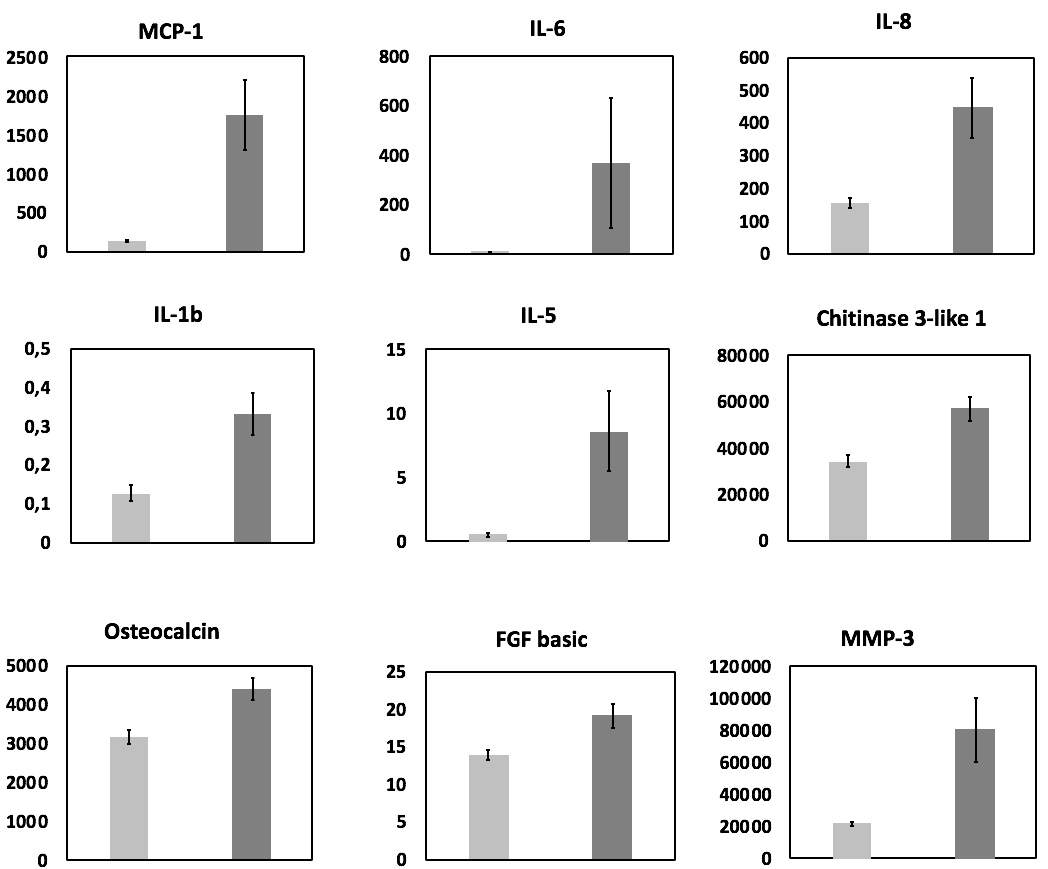
Figure 2. Bar plots representing the follicular fluid concentrations (pg/mL) of the nine cytokines found significantly different between endometriosis (dark gray) and control (light gray) patients. All patients ( n = 87) were included and data were log-transformed before Student test. Benjamini-Hochberg correction was applied to observed p -values for correction of risk I inflation. Error bars represent standard error of the mean (S.E.M.).